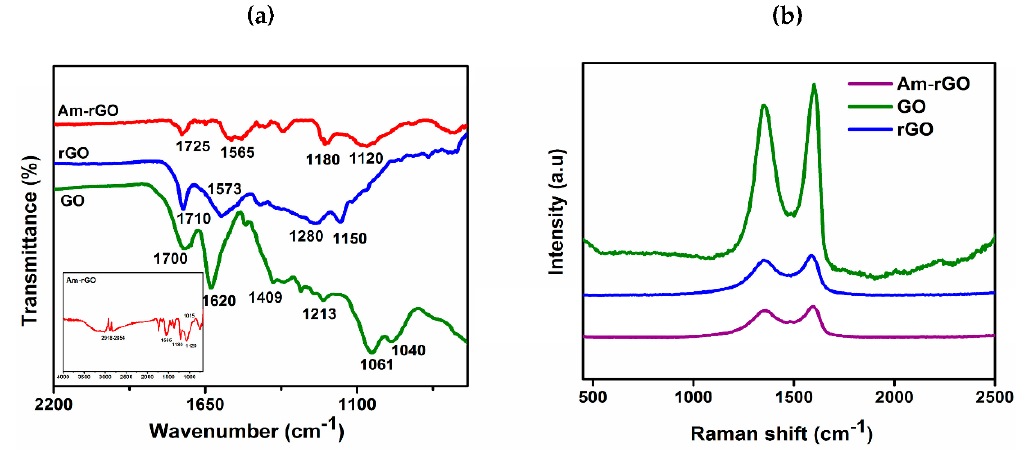
Figure 3. ( a) FTIR and ( b ) Raman spectra of GO, rGO and Am-rGO.